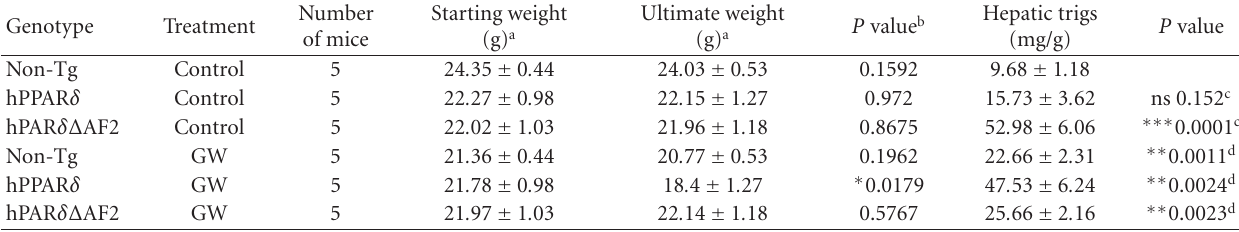
Table 1: E ff ect of GW501516 treatment on body weight (g) and hepatic triglycerides (mg/g of liver) in nontransgenic, hPPAR δ and hPPAR δ Δ AF2